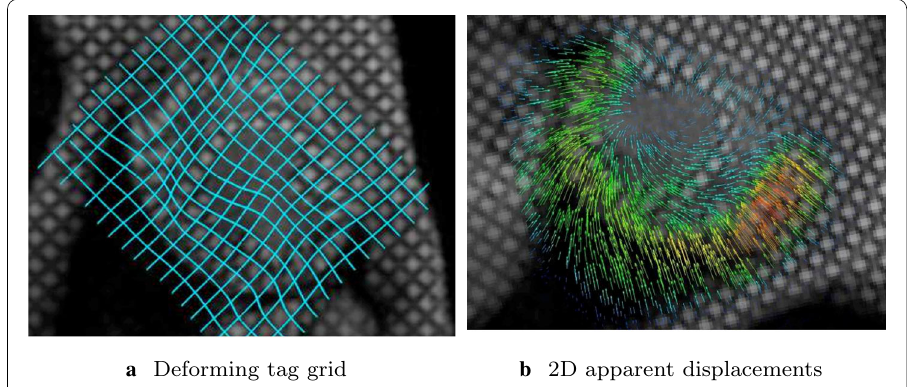
a Deforming tag grid b 2D apparent displacements Fig. 3 Example of a tag grid and apparent displacements extracted from real tagged-MR images. Apparent displacements obtained from inTag plugin of OsiriX software